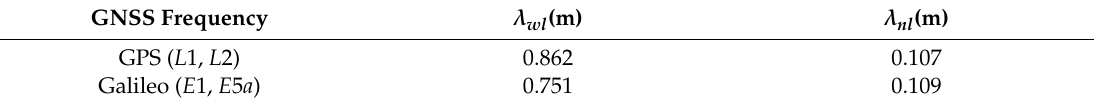
Table 1. Values for wide-lane and narrow-lane